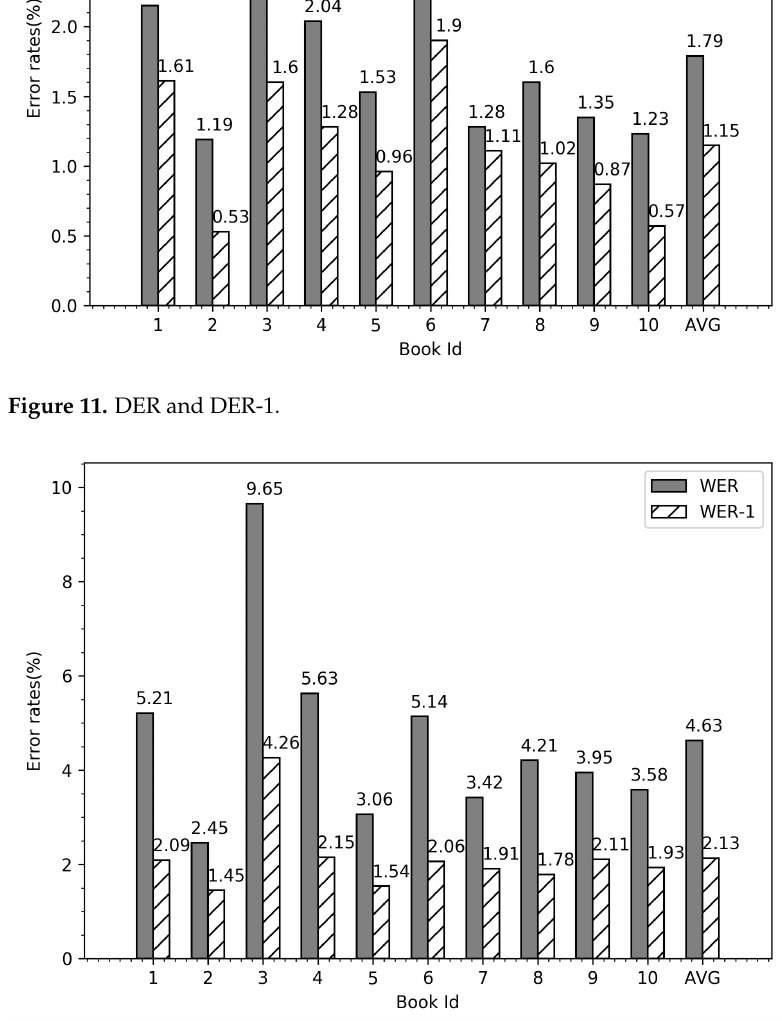
Figure 12. WER and